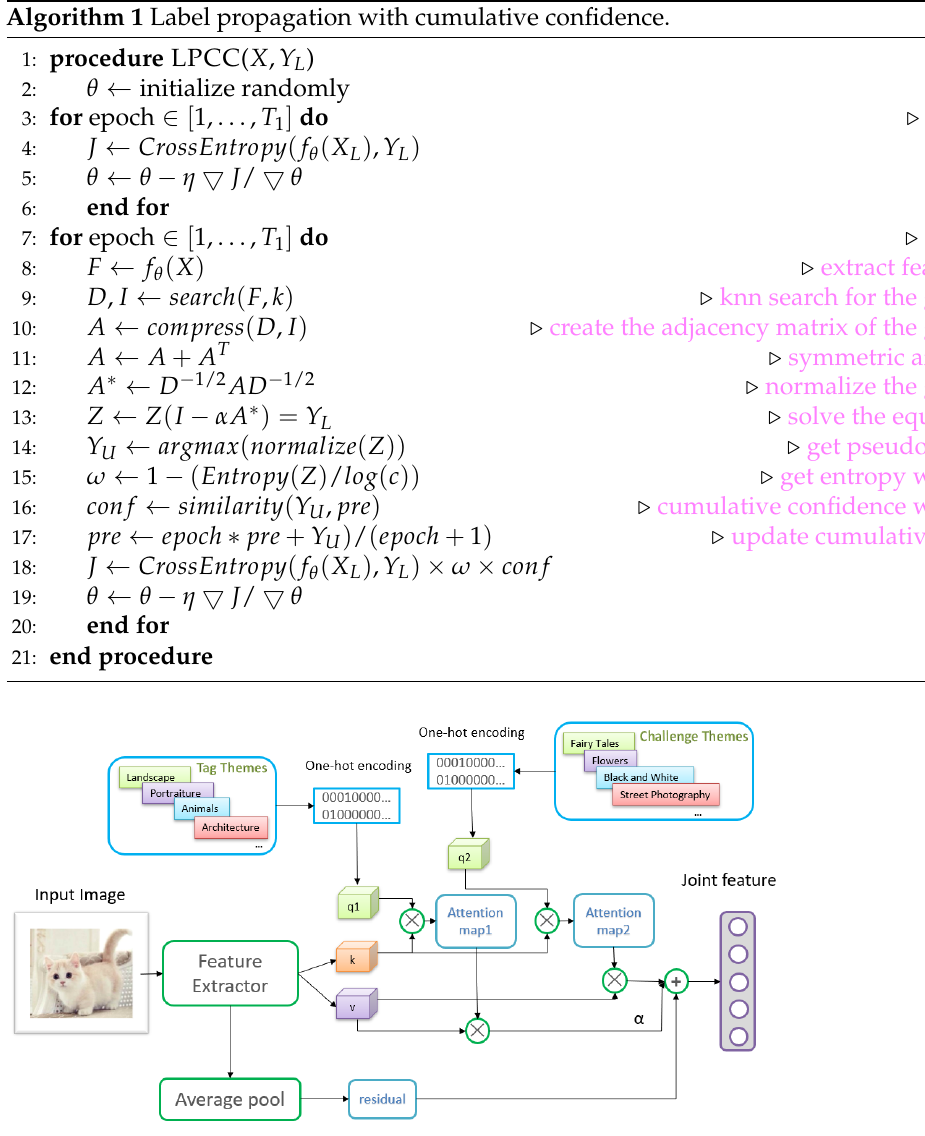
Figure 2. Details of our theme-aware attention network (TAAN). The TAAN consists of an image feature extractor (backbone), a self-attention-based theme encoder and a residual connection